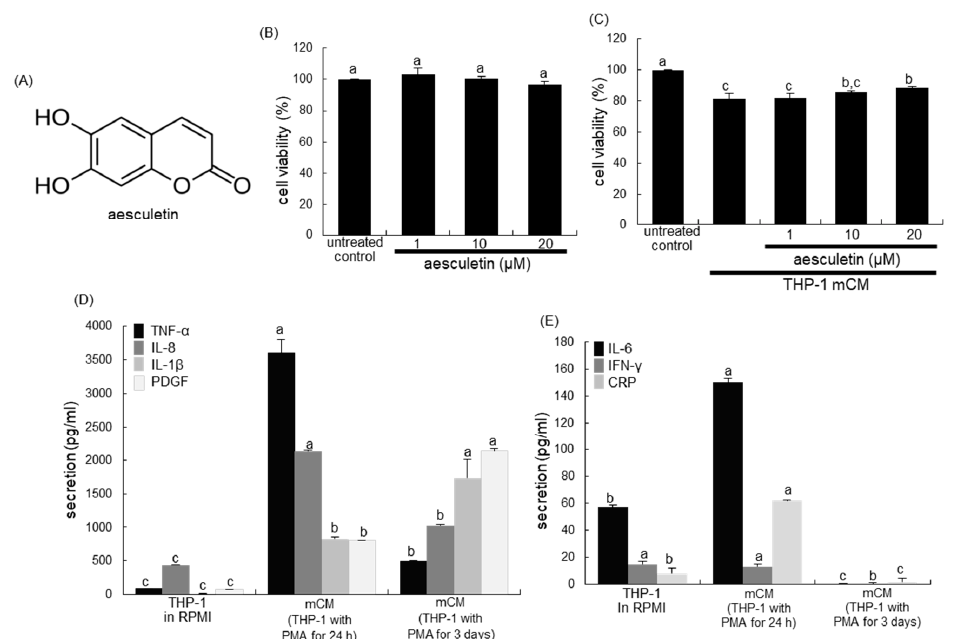
Figure 1. Chemical structure ( A ) and A549 cell toxicity of aesculetin ( B ) in THP-1 monocyte-derived macrophage conditioned media (mCM, C ). Alveolar epithelial A549 cells were incubated for 24 h with 1–20 µ M aesculetin ( B ), or cells were cultured with 1–20 µ M aesculetin for 24 h in mCM ( C ). Cell viability was measured by 3-(4,5-dimetylthiazol-yl)-diphenyltetrazolium bromide assay and expressed as percent cell survival relative to untreated controls (cell viability = 100%, mean ± SEM, n = 5). THP-1 monocytes were exposed to phorbol myristate acetate (PMA) for 1 day or 3 days and media were collected ( D , E ). Release of tumor necrosis factor- α (TNF- α ), interleukin (IL)-8, IL-1 β , platelet-derived growth factor (PDGF), IL-6, interferon- γ (IFN- γ ) and C-reactive protein (CRP) in mCM obtained from THP-1 monocytes exposed to 50 ng/mL PMA for 1 day or 3 days was detected by using ELISA kits. Respective values in bar graphs not sharing a common letter indicate significant different at p < 0.05.